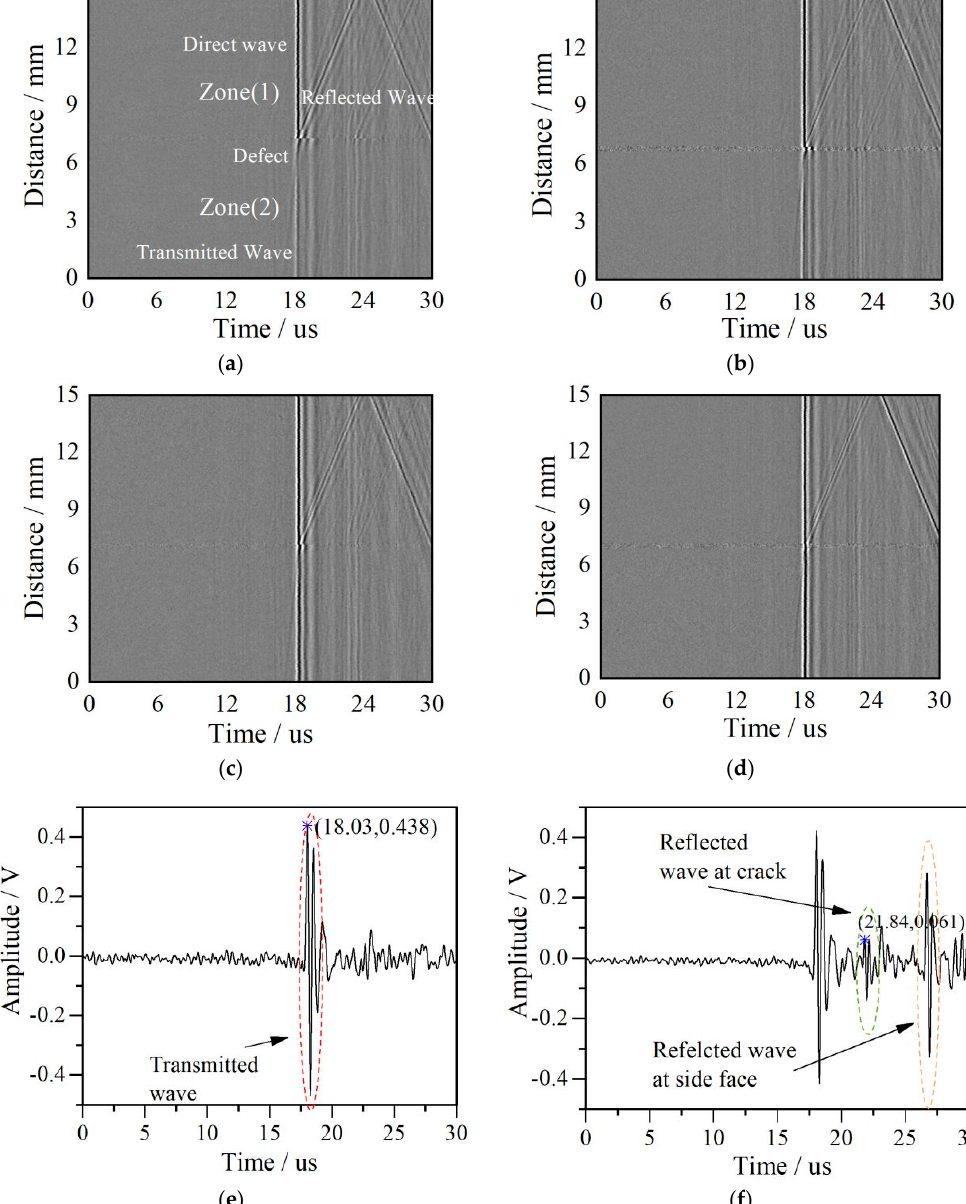
Figure 12. B-scanning images of surface cracks ( a ) The notch depth is 0.5 mm. ( b ) The notch depth is 0.4 mm. ( c ) The notch depth is 0.3 mm. ( d ) The notch depth is 0.2 mm. ( e ) Transmitted signals in the time domain. ( f ) Reflected signals in the time domain.